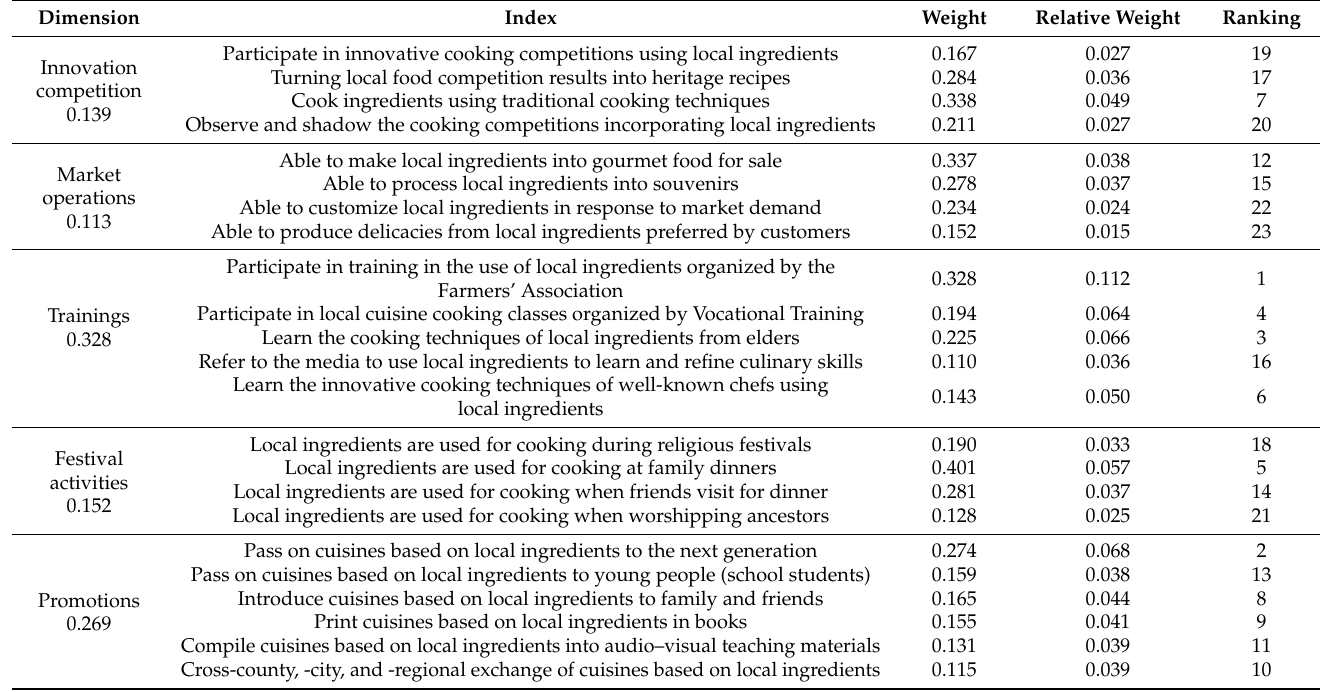
Table 2. Analysis of the overall professionals’ weighting of the farmers’ use of local food culture inheritance and sustainable innovation development